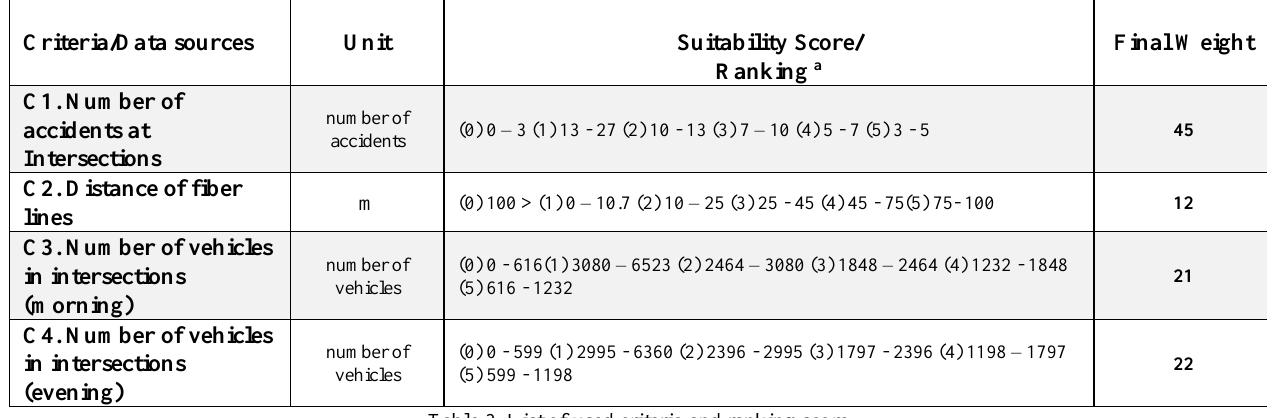
Table 3. List of used criteria and ranking score.